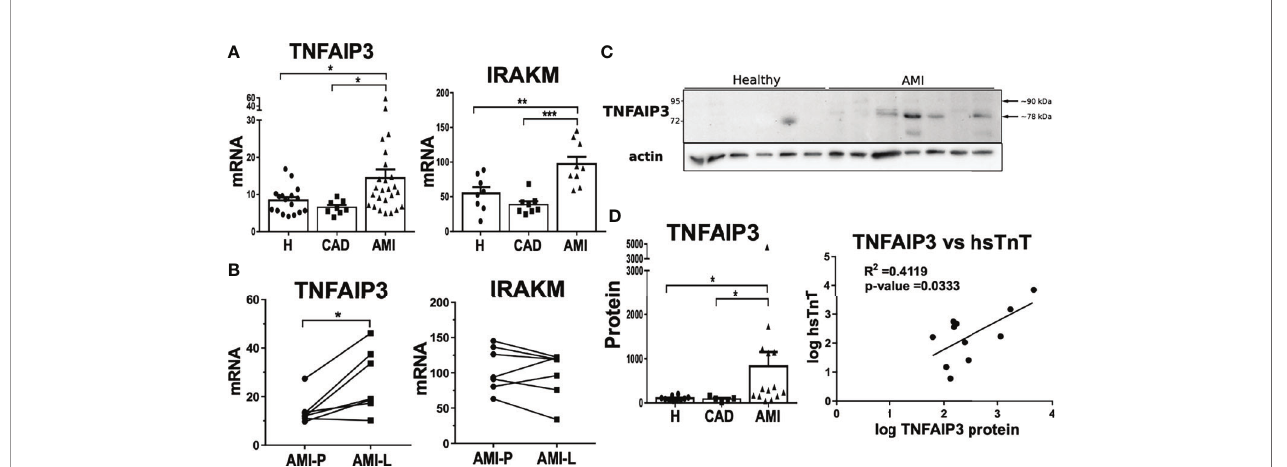
FIGURE 6 | Upregulation of negative feedback loop regulators TNFAIP3 and IRAKM linked to attenuated in fl ammatory phenotype in AMI CD14 + monocytes. (A) Both TNFAIP3 and IRAKM mRNA was signi fi cantly increased in circulating CD14 + monocytes from AMI patients compared to healthy subjects or CAD patients (n = 8-27). (B) In contrast to IRAKM, the mRNA expression of TNFAIP3 was even further upregulated in lesional monocytes compared to peripheral cells within the same AMI patients (n = 7). (C) TNFAIP3 protein levels were also signi fi cantly higher in monocytes from AMI patients. (D) Moreover, TNFAIP3 protein showed a direct correlation with high sensitive Troponin T (hsTnT) levels. *p < 0.05; **p ≤ 0.01; ***p ≤